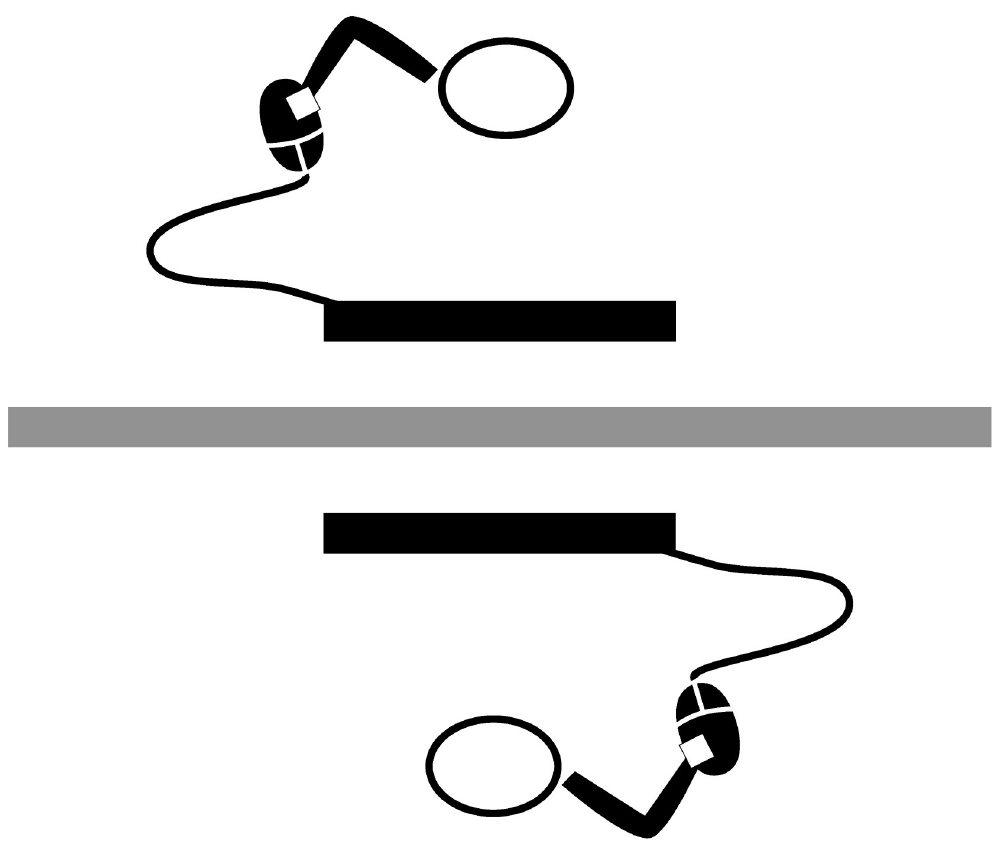
Fig 5. The physical setup of Experiment 3. Participants are sitting opposite each other separated by a partition